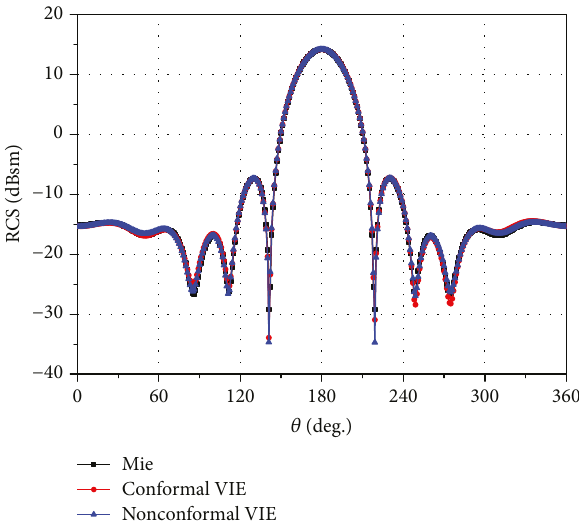
= 1 5 – 1 5 j 1 = 0 3m , and an outer 1